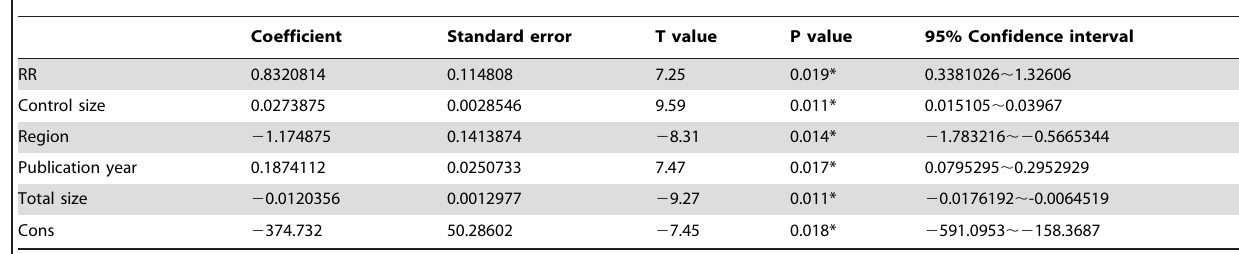
Table 4. The meta-regression results among 8 studies.